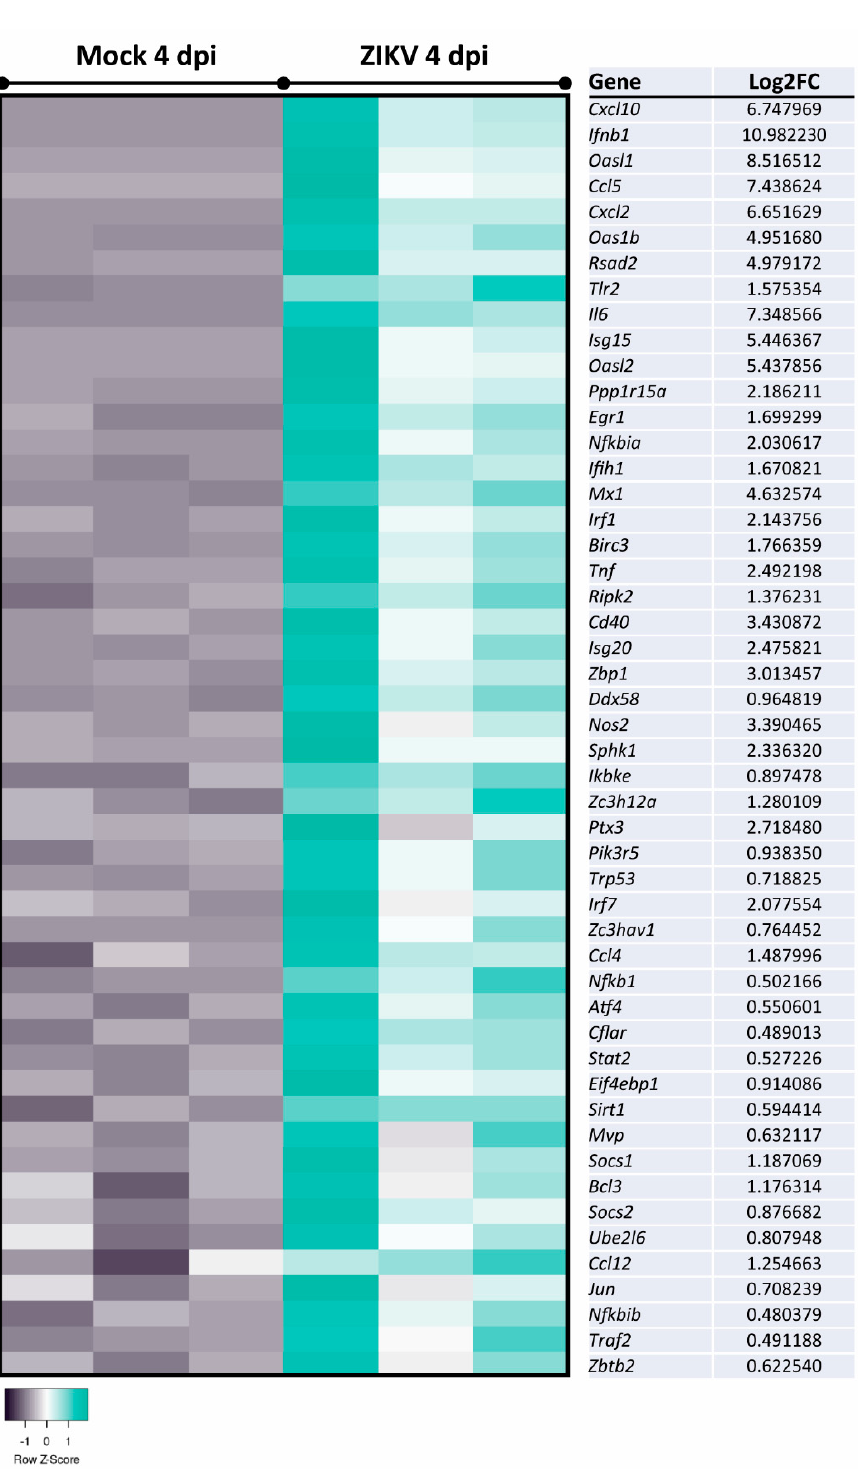
Figure 6. Analysis of DEGs involved in the control of viral replication in mature CNS cultures. Expression analysis of DEGs in ZIKV-infected samples versus mock-infected samples at 4 dpi by IPA revealed DEGs implicated in the reduction of viral replication, including Ccl5 , Cxcl10, and Ifit1 . Displayed DEGs were grouped and categorized using the disease and function tool. Log2FC: Log2 fold change expression value.